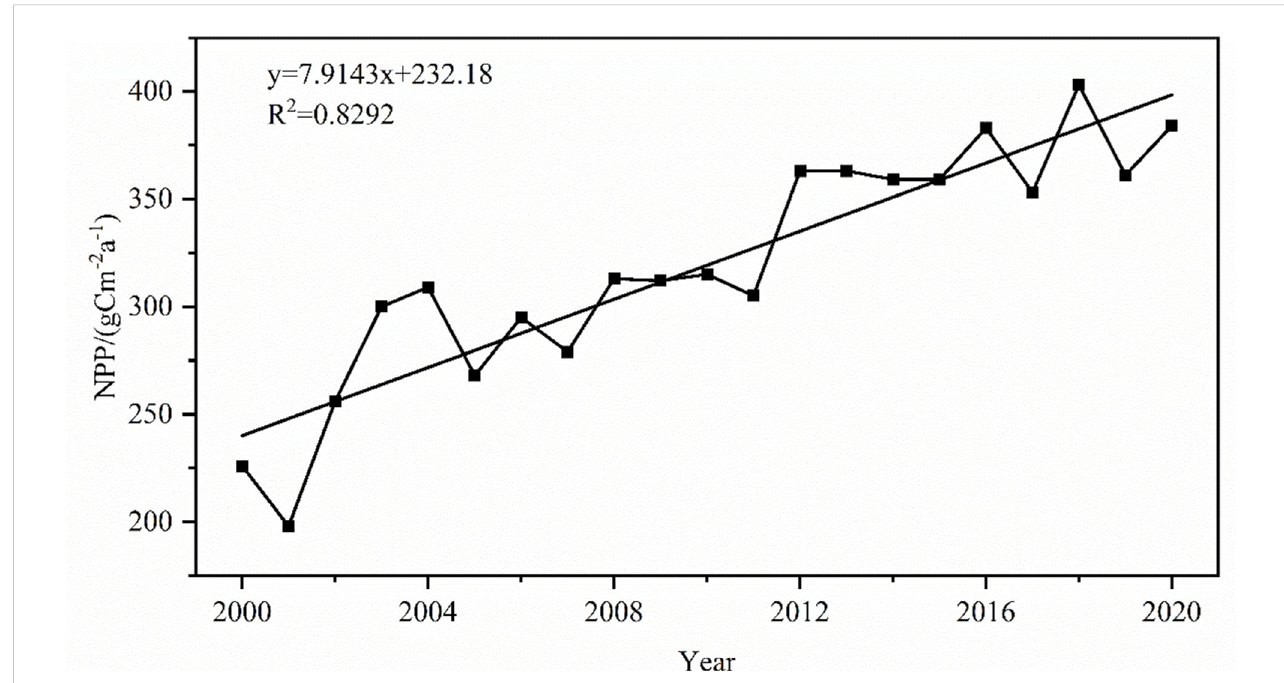
FIGURE 2 The changing trend of the annual average NPP from 2000 to